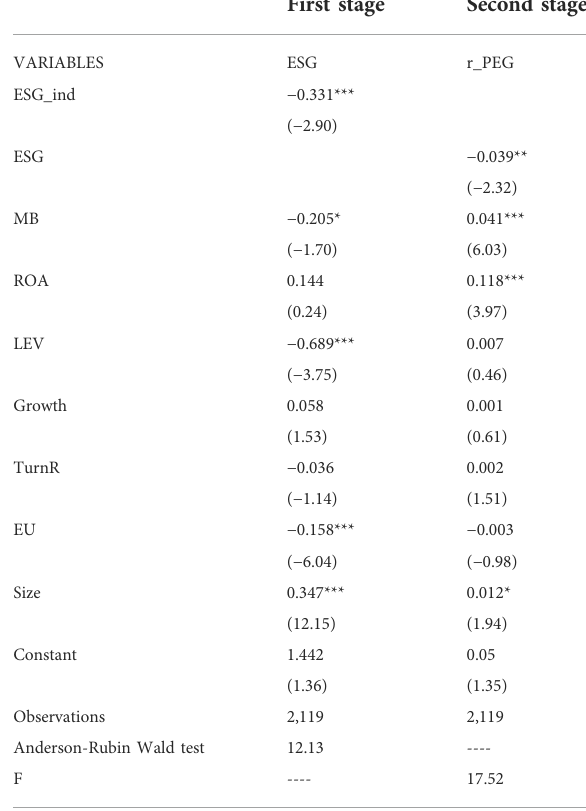
TABLE 6 The Robustness checks of Instrumental variable method.